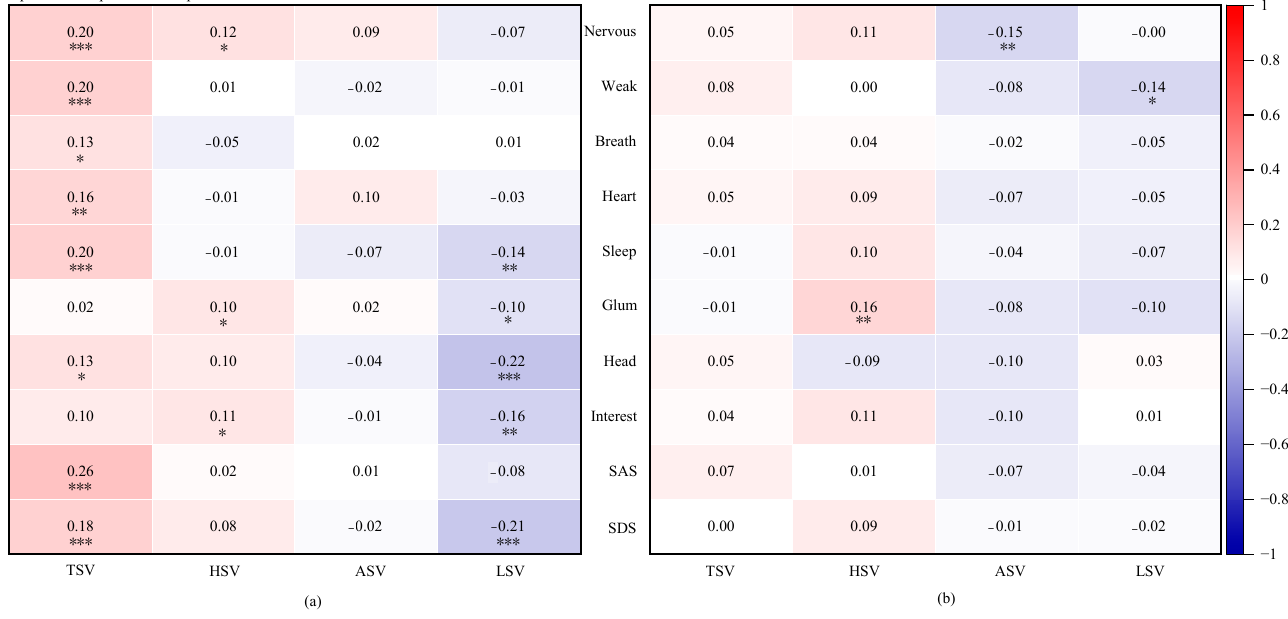
Figure 10. Results of the correlation analysis between the environmental sensation and psychological state of ( a ) males and ( b )